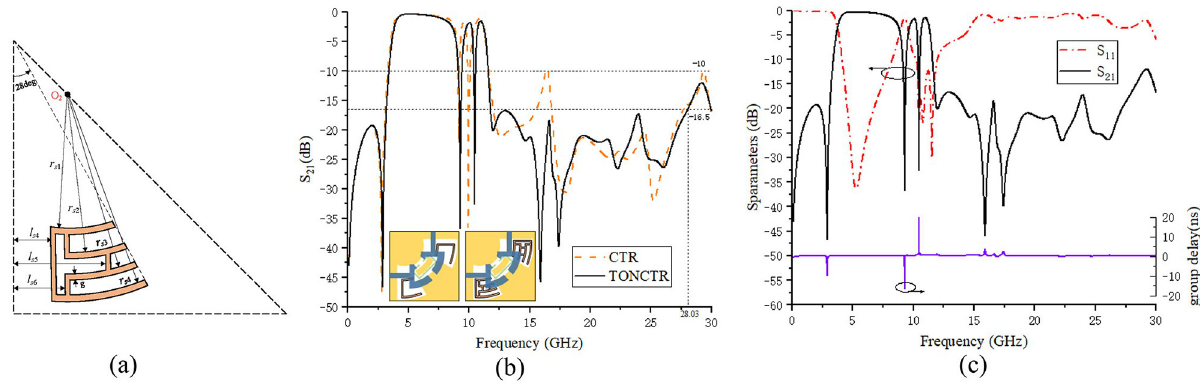
Fig 16. TONCTR structure and comparative response curve. (a) TONCTR structure diagram. (b) comparison of CTR and TONCTR response curves. (c) S-parameter simulation results and group delay results.